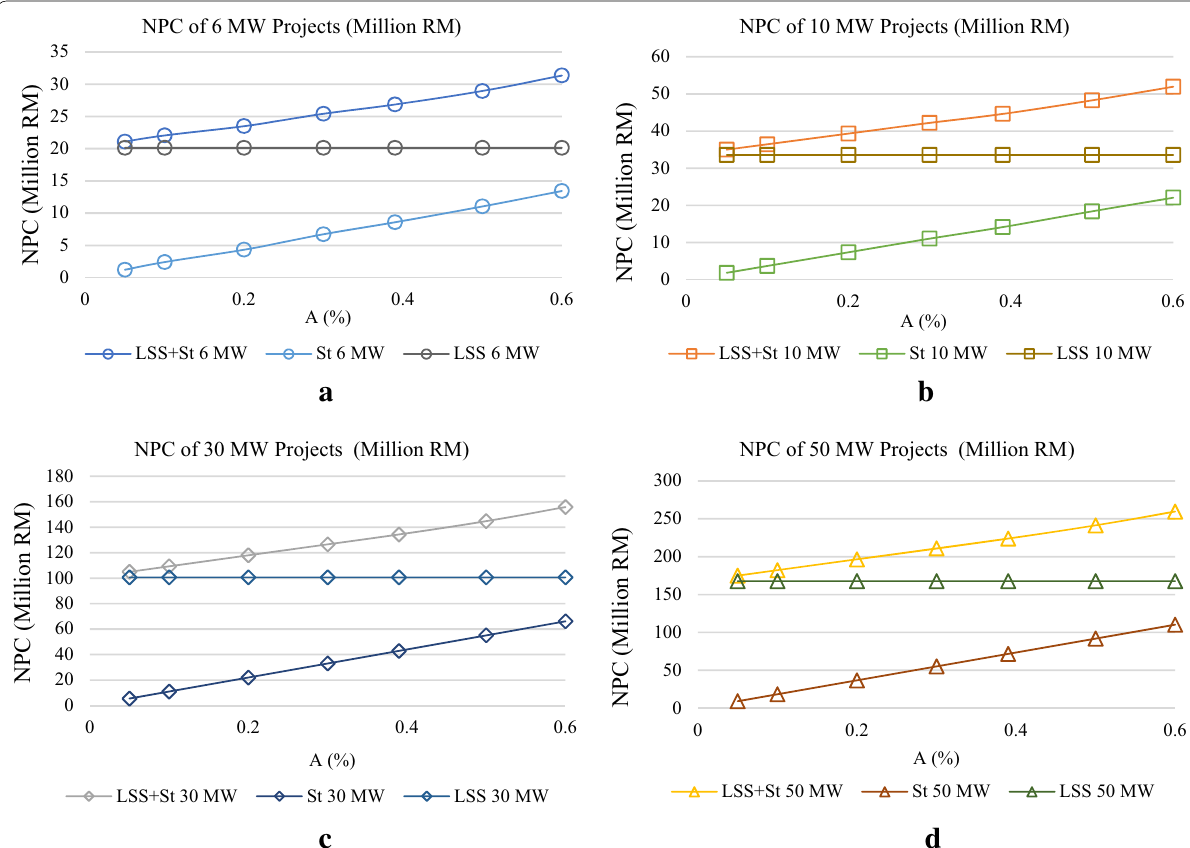
Fig. 13 Net present cost of the different investment types for each LSS capacity in Perak. a 6-MW projects, b 10-MW projects, c 30-MW projects, d 50-MW